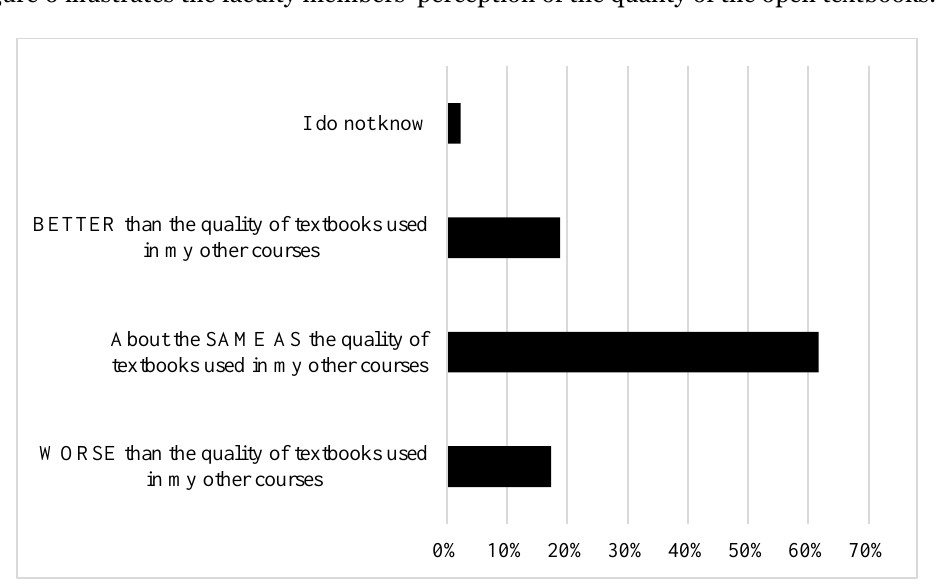
Figure 6 . Faculty members’ perceptions of the quality of open